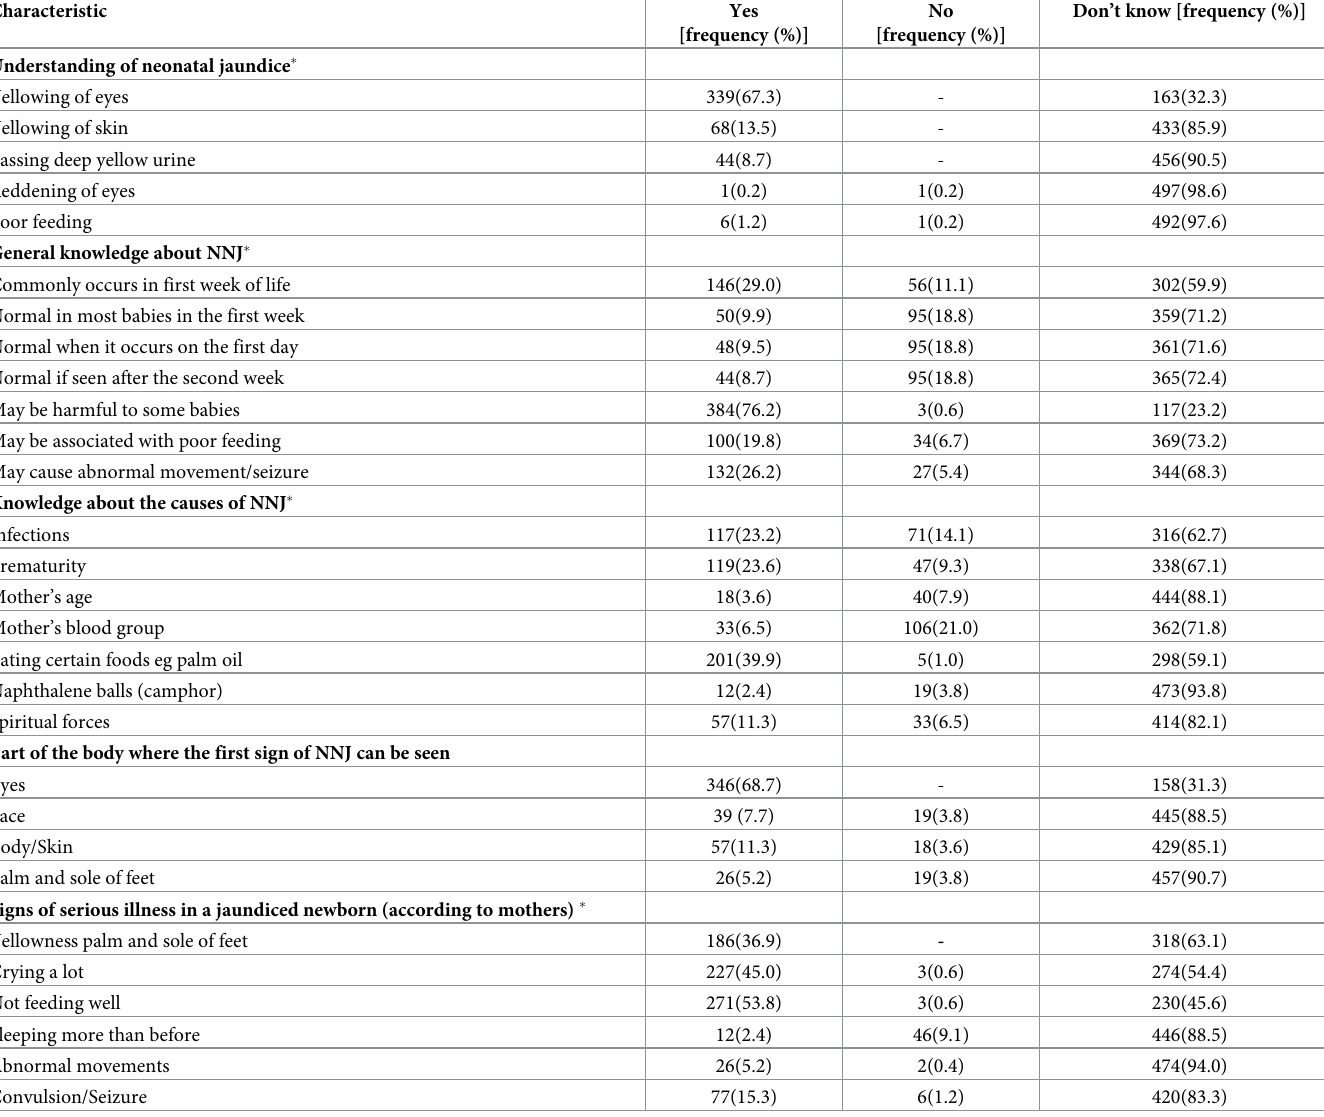
Table 2. Knowledge of the mothers about the timing, causes and signs/symptoms of neonatal jaundice (N = 504).